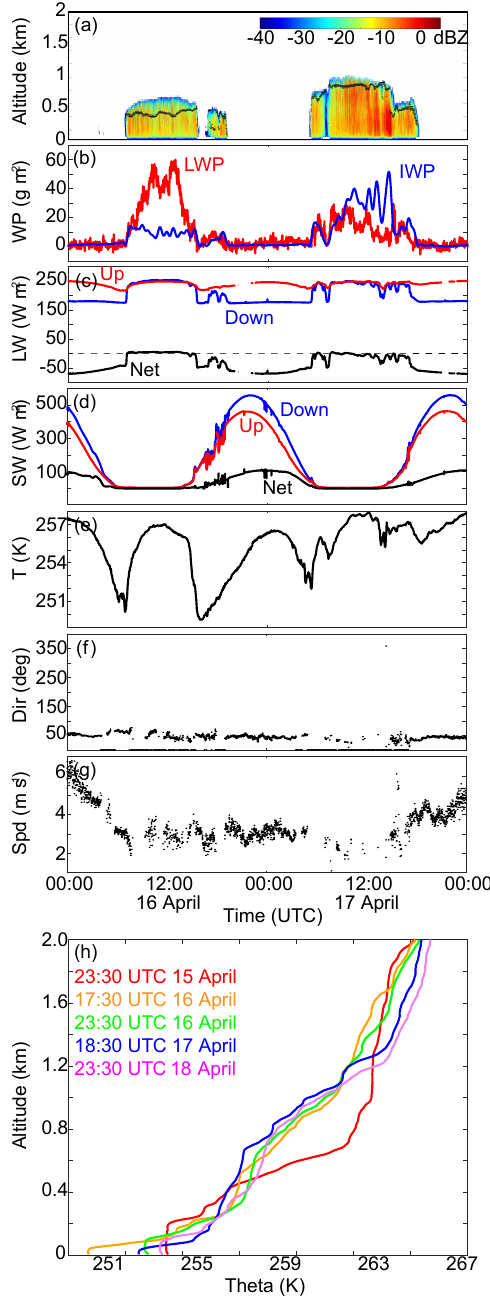
Figure 1. Measurements at Oliktok Point, Alaska, 15–17 April 2015. (a) Ceilometer (black dots) and Ka-band cloud radar reflectiv- ity (colored shading). (b) LWP and IWP, in units of gm − 2 . (c) LW and (d) SW surface radiation measurements, in units of Wm − 2 . (e) Surface air temperatures. (f) Surface wind direction, in units of de- grees. (g) Surface wind speed, in units of ms − 1 . (h) Radiosondes at approximately 23:30UTC on 15 April, 17:30 and 23:30UTC